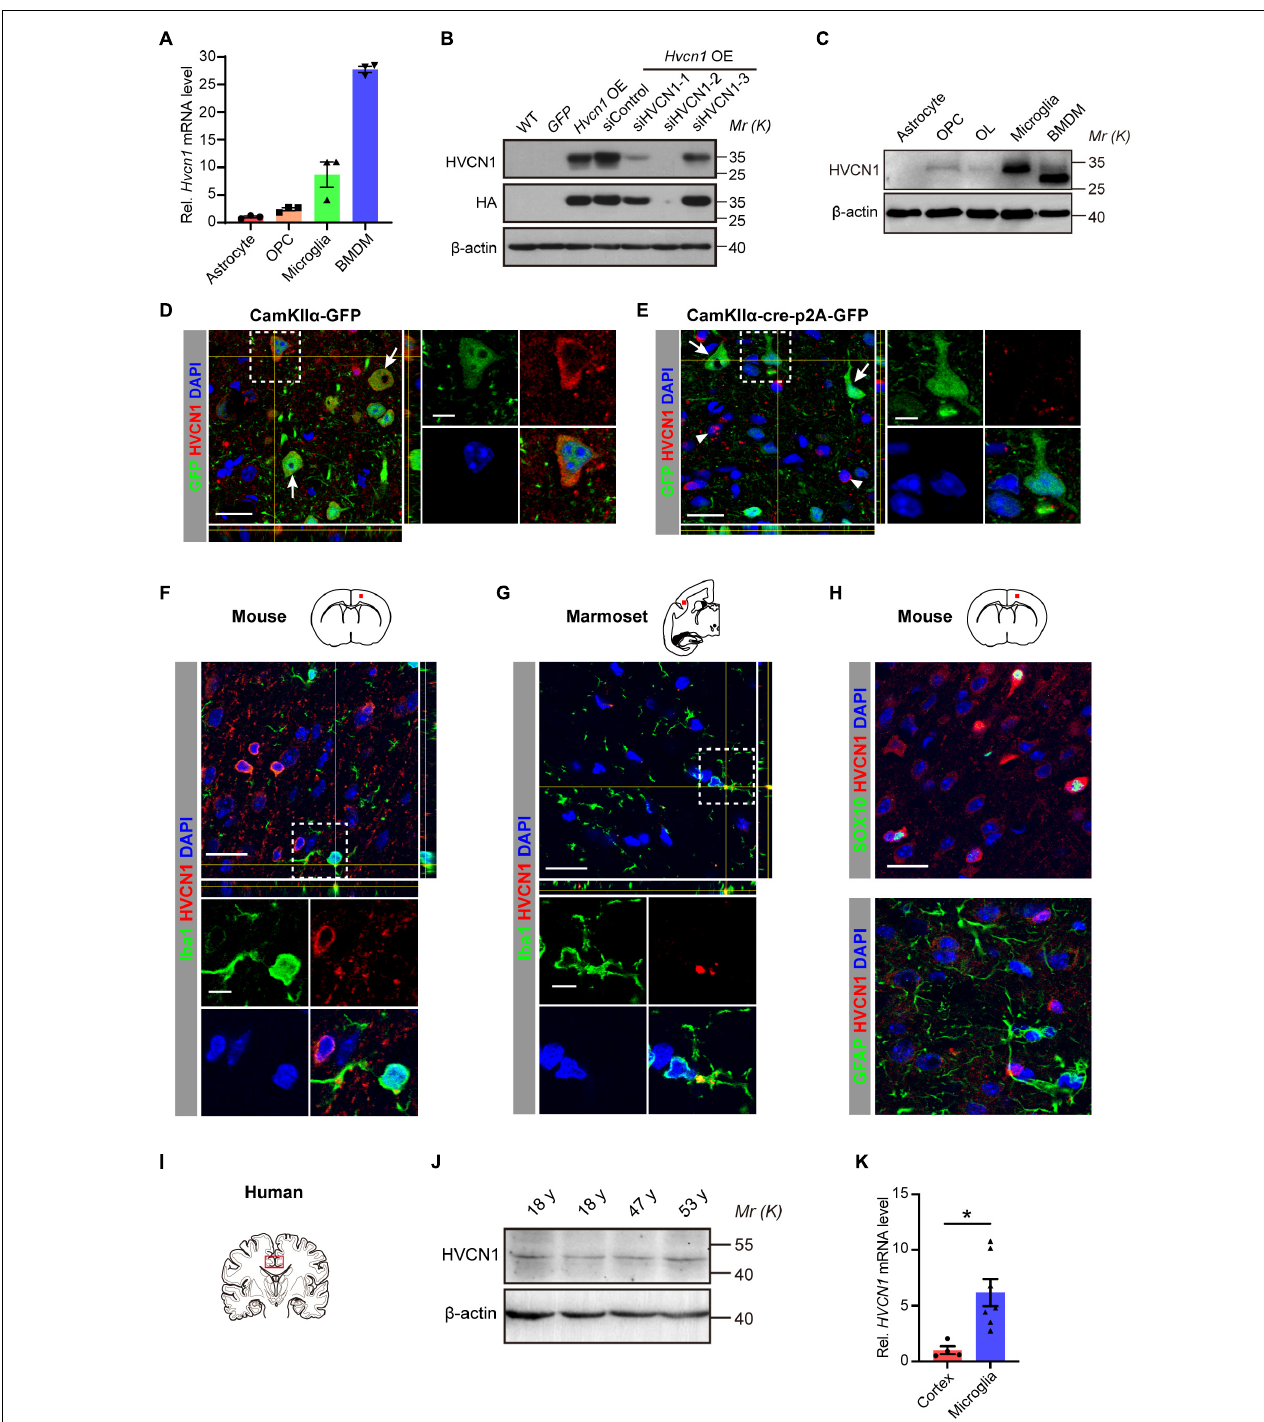
FIGURE 1 | Expression of HVCN1 in microglia in vitro and in the normal adult cerebral cortex of mouse, marmoset, and human. (A) Hvcn1 mRNA is highly expressed in primary cultured mouse bone marrow derived macrophages (BMDM) and rat microglia, while exhibits much lower level in oligodendrocyte progenitor cells (OPCs) and astrocyte of the rat brain ( n = 3). (B) Specificity validation of the HVCN1 antibody in vitro by Western blot and Hvcn1 is overexpressed (OE) by transfecting with pLenti-CMV-HVCN1-HA-p2A-GFP plasmid whereas knocked down with siHVCN1 in COS-7 cells. (C) Representative images of Western blot of primary cultured cells: HVCN1 protein is expressed highly in rat microglia and mouse BMDM while exhibits low levels in rat OPCs, oligodendrocyte (OL), and astrocyte. (D,E) Specificity validation of HVCN1 antibody in vivo by immunofluorescence: targeted deleting Hvcn1 in CamKII α + neurons of Hvcn1 fl / fl mice by focal